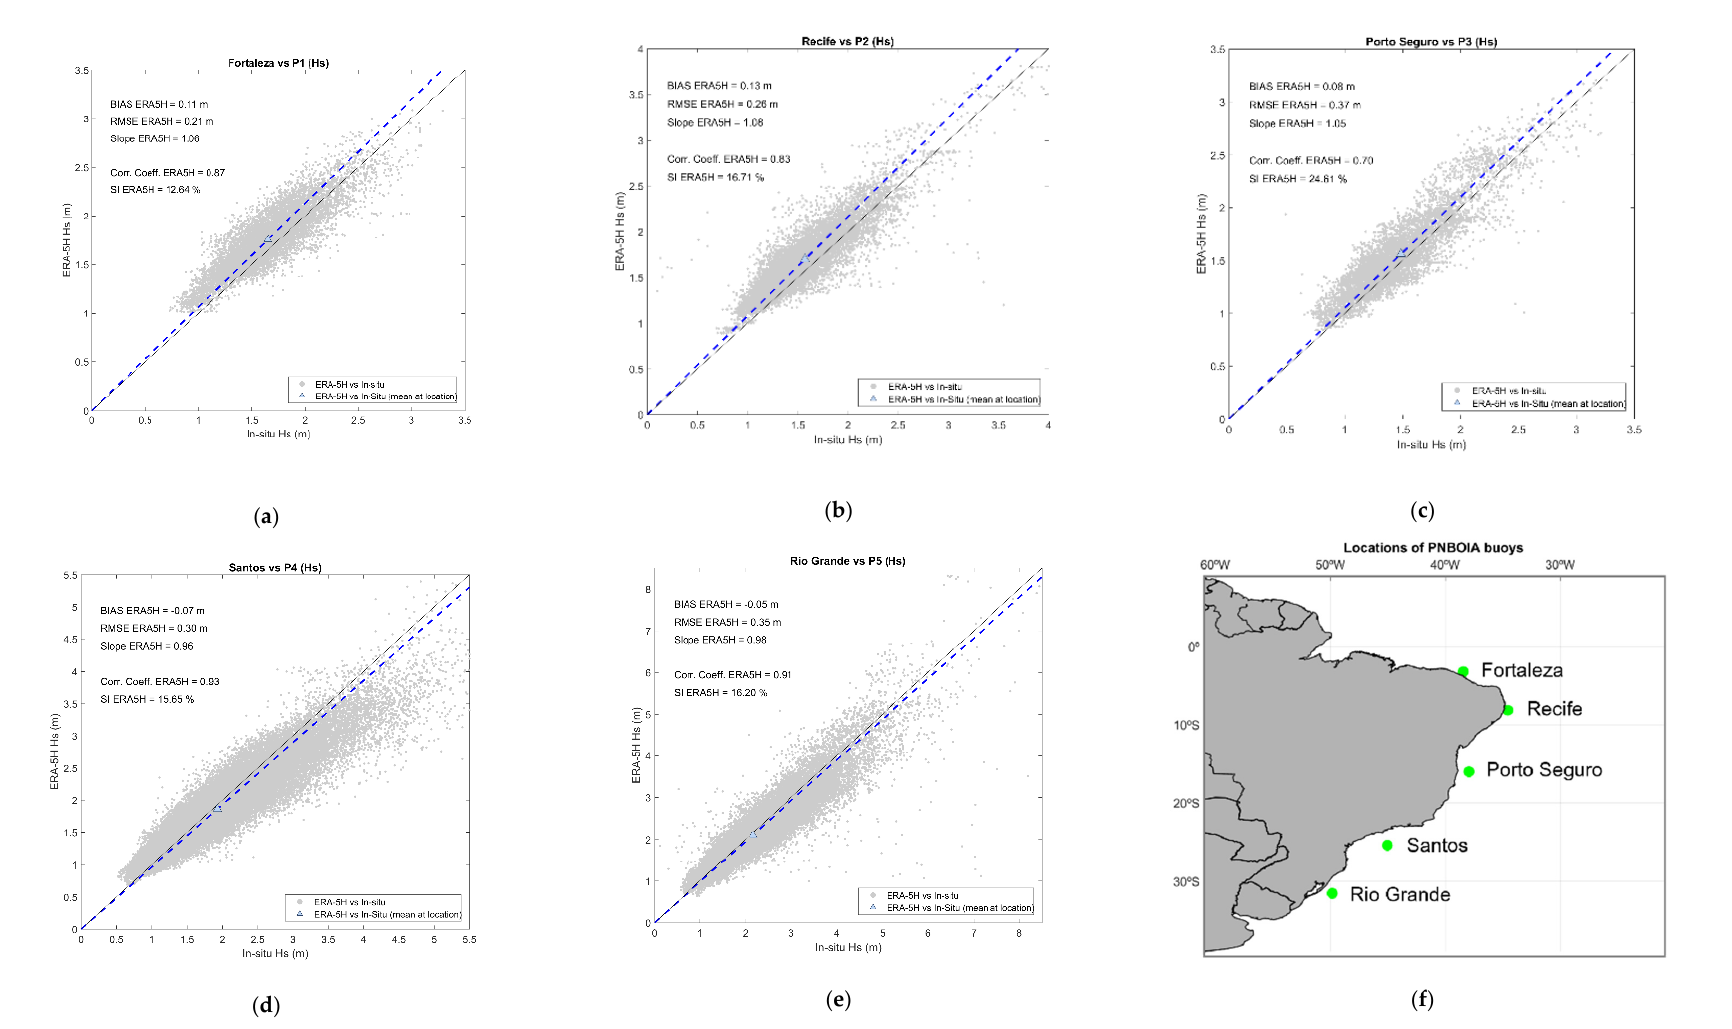
Figure 10. Scatterplot of in situ H s observations (m) vs. ERA-5H H s (m) for Fortaleza vs. P1 ( a ), Recife vs. P2 ( b ), Porto Seguro vs. P3 ( c ), Santos vs. P4 ( d ), and Rio Grande vs. P5 ( e ) with the respective statistics ( BIAS , RMSE , slope, correlation coefficient, and SI ) between observed H s and their respective ERA-5H key points. The blue dashed line represents the linear regression fit. ( f ) Locations of the